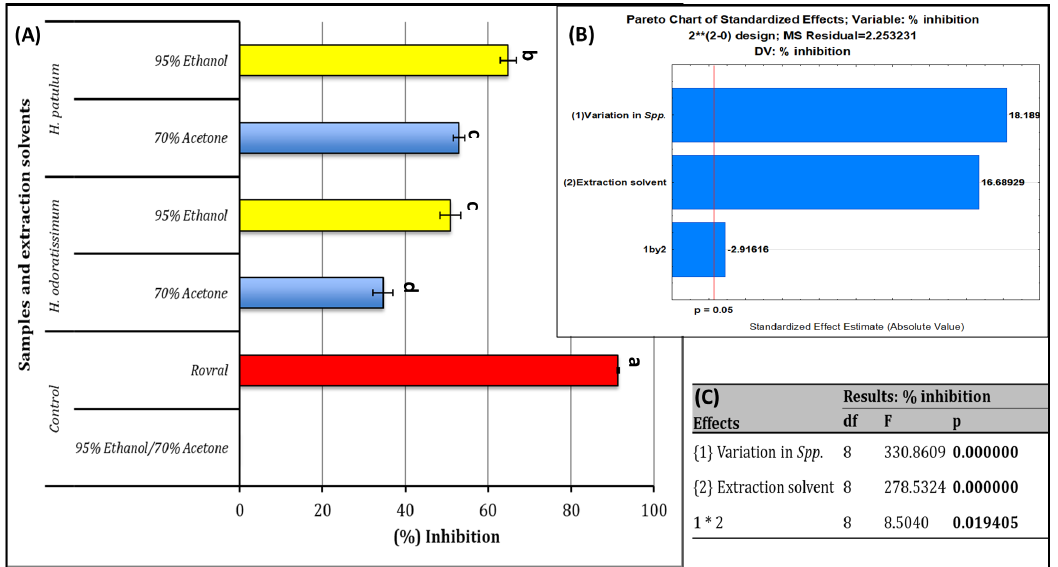
Figure 1. ( A ) Antifungal screening of aqueous acetone and ethanol extracts of H. odoratissimum (L.) and H. patulum by disk diffusion method against Botrytis cinerea . Mean values ( n = 9) of microbial percentage inhibition with standard error bars. Different letters are significantly different based on Duncan’s Multiple Range Test at p ≤ 0.05. ( B ) Pareto analysis showing the effects of extraction solvent, variation in Spp., and interaction effects at 95% confidence indicated as the vertical red line. ( C ) Statistical parameters. * Colour only online.